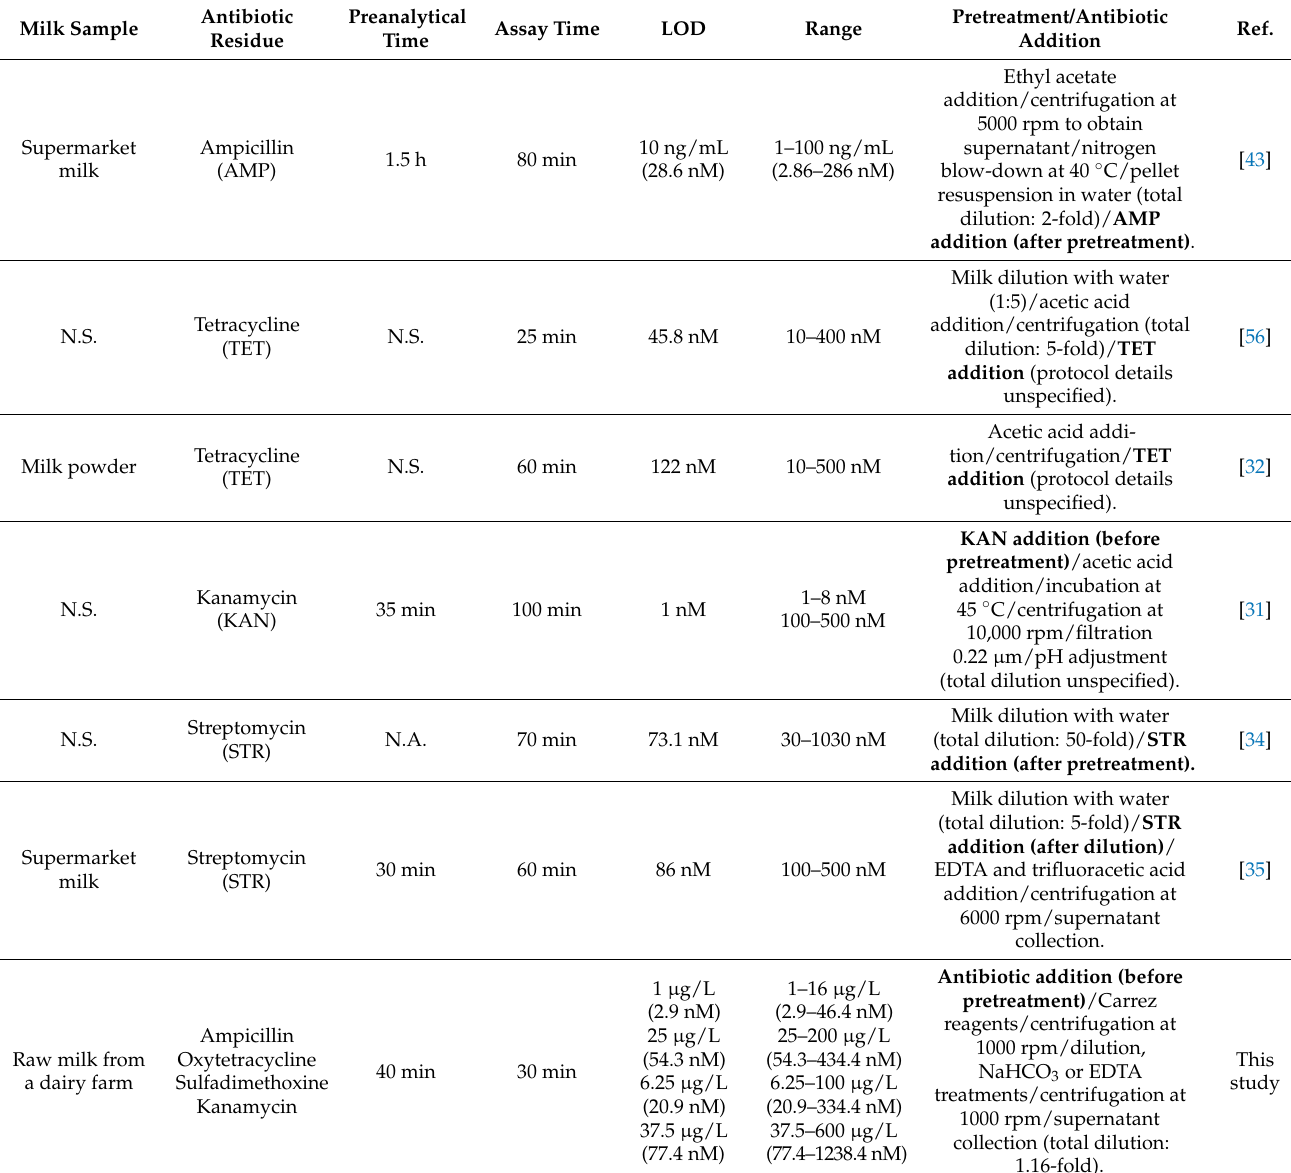
Table 5. Colorimetric AuNP-based aptasensors for the determination of antibiotics in